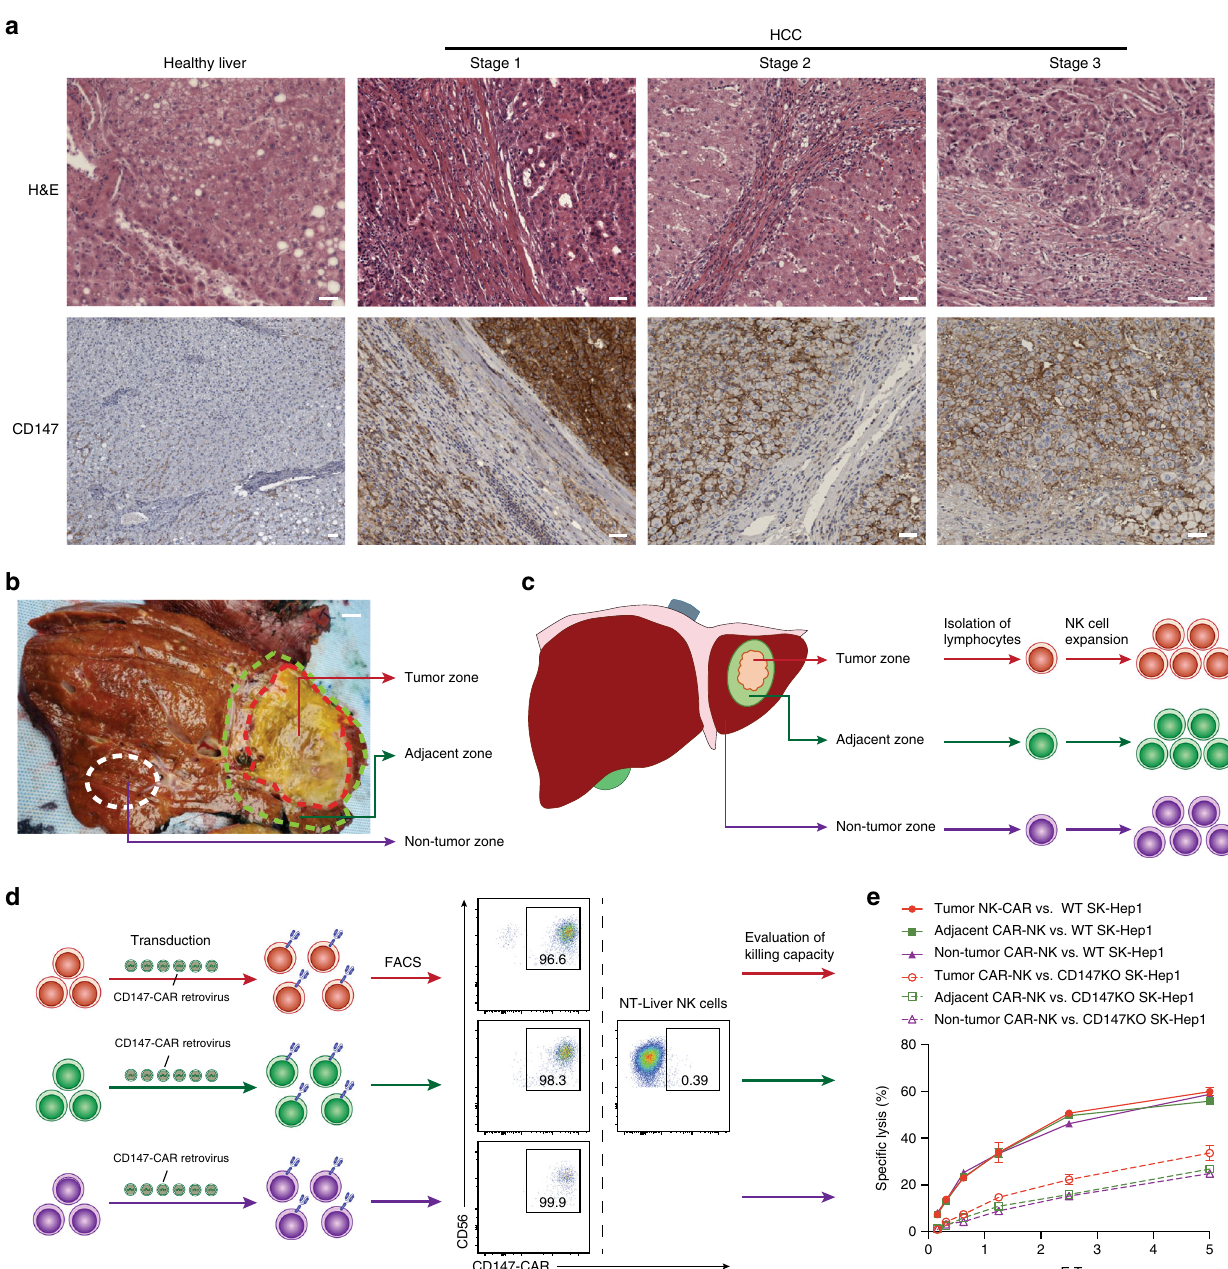
Fig. 5 Patient-derived Primary CD147-CAR-NK cells speci fi cally kill CD147 + tumor cells in vitro. a , b Representative H&E and IHC staining of liver samples from different stages of one HCC patient. Scale bar, 200 µ m. c Diagram of experimental design of HCC sample acquisition from different areas of liver cancer tissues. Brie fl y, three regions of interest (tumor zone, adjacent zone, and non-tumor zone) were obtained. Primary NK cells were isolated from these zones, indicated by different colors. Scale bar, 2 cm. d Flow cytometry analysis of CD147-CAR + primary NK cells from different zones of liver tissues. e Cytotoxicity of primary CD147-CAR-NK cells was measured by 4-h standard Cr 51 release assays. All results are mean ± SEM. Data are from at least two